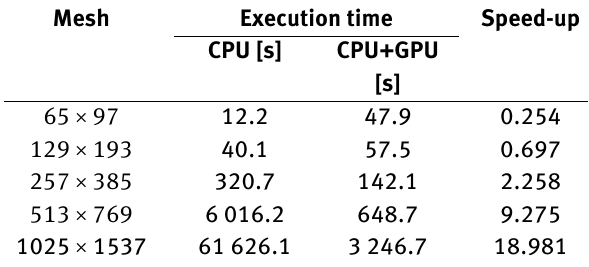
Table 3: Execution times and the speed-up of computations (CPU – author’s own program, CPU+GPU – the CUDA environment).